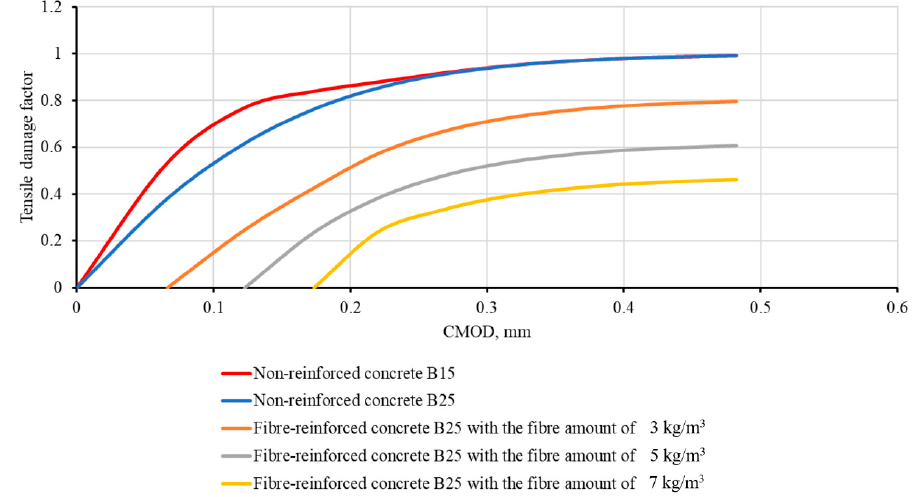
Figure 4. Tensile damage factor versus CMOD according to CMOD test data.